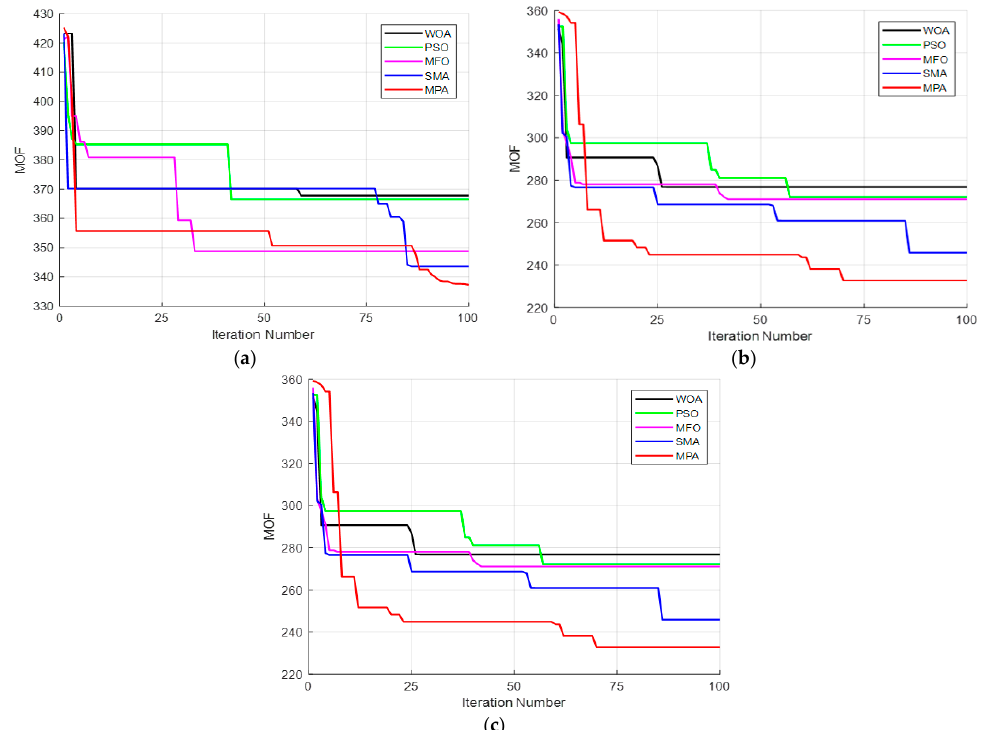
Figure 8. Characteristics of convergence of the algorithms for the IEEE 33-bus: ( a ) PVDG case; ( b ) WTDG case; ( c ) Hybrid PVDG-WTDG case.